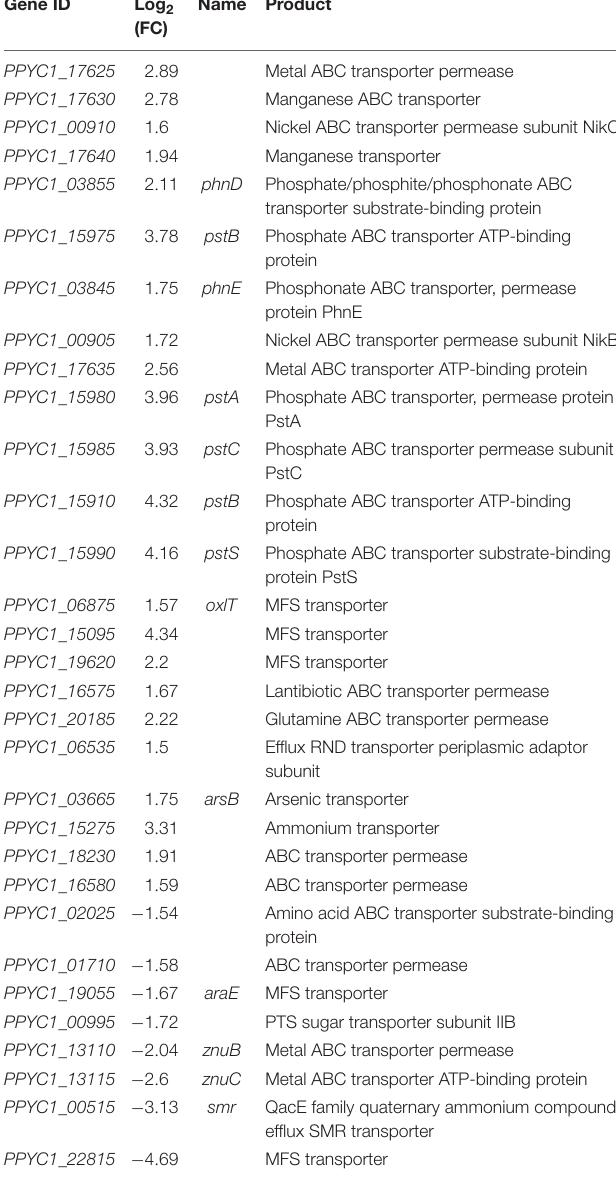
TABLE 5 | Effects of tobacco on the genes related to transport in strain